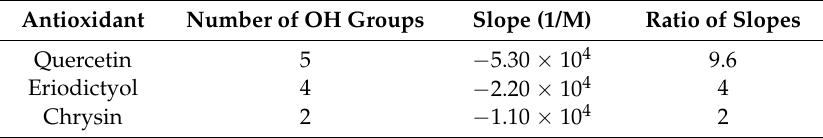
Figure 14. Collection efficiency for chrysin. Table 2. Correlation data for antioxidant scavenging of superoxide. Slopes from the linear curves depicted in Figures 13 and 14, and that calculated when including only data for low concentrated quercetin, e.g., left part of Figure